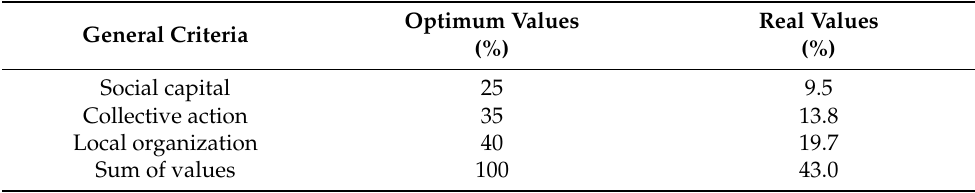
Table 10. Composed indicator of community forest governance in San Miguel